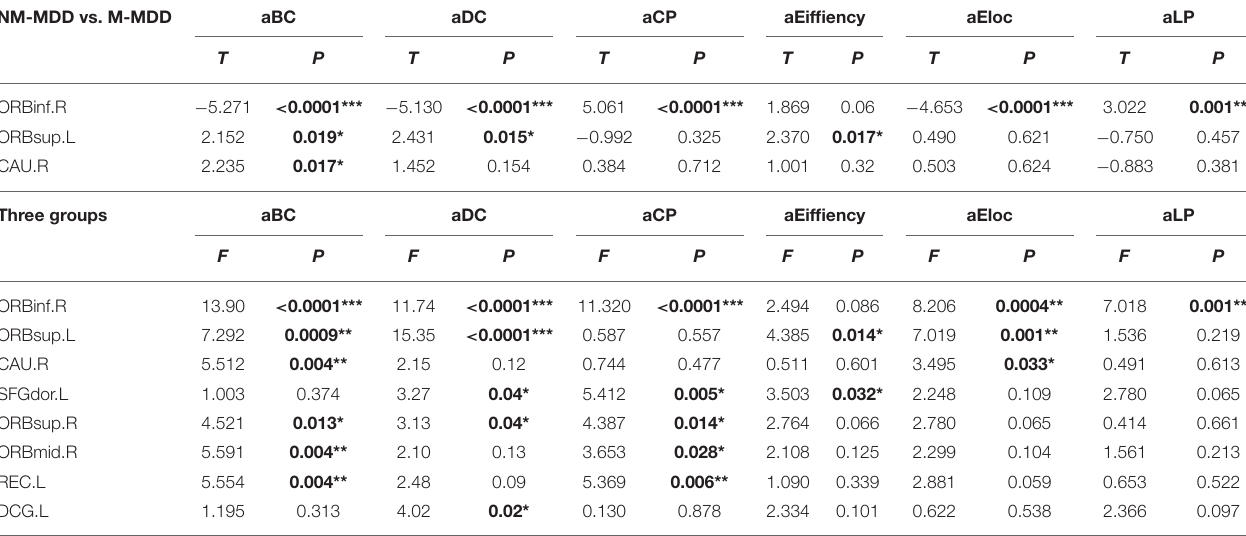
TABLE 2 | ANCOVA results of nodal parameters differences among patients with healthy groups. NM-MDD vs.